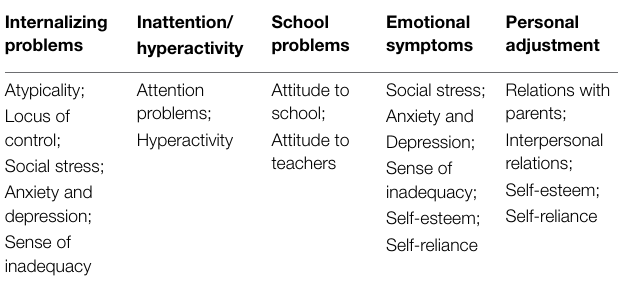
TABLE 3 | Description of variables measured by BASC-3 (Reynolds and Kamphaus,